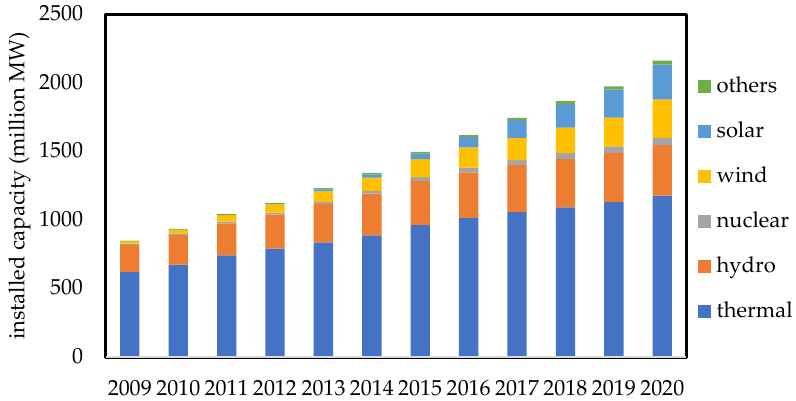
Figure 4. Installed capacity of China’s power supply structure from 2009–2020.